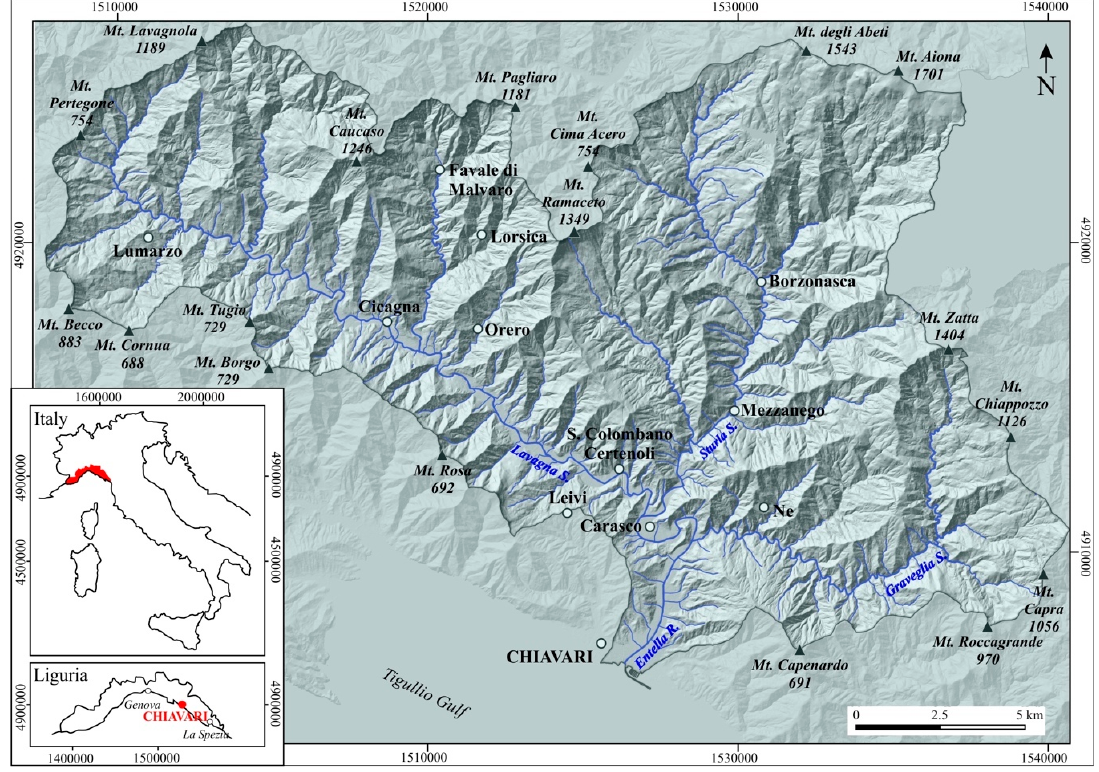
Figure 1. Geography of the Entella River basin.